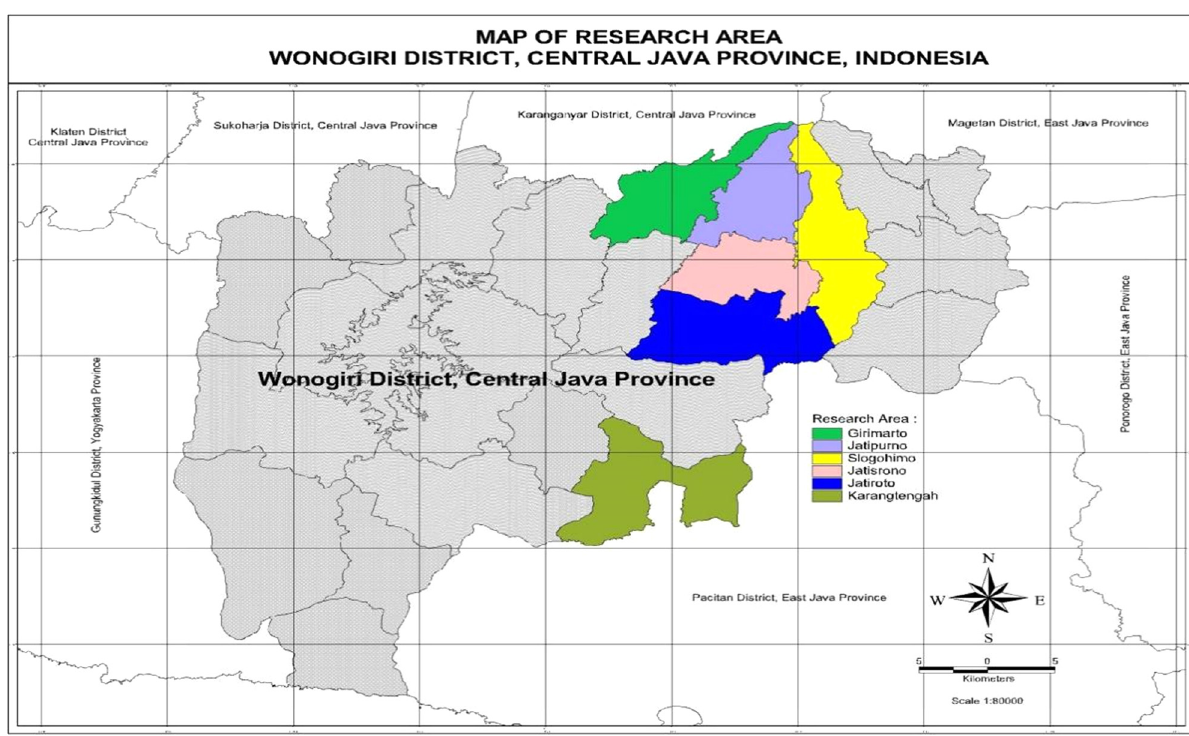
Figure 2: Study location in